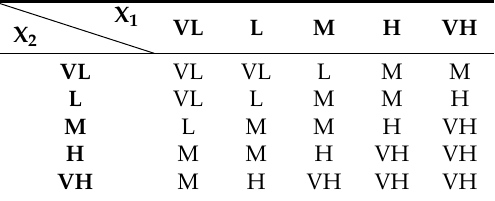
Table 2 indicates the fuzzy logic rules on the average rule-based method for M 1 _FIS. It is a 5 × 5 matrix and each entry in Table 2 is the water supply pipeline risk index. Table 2. Average rule-based mechanism for water supply pipeline risk index fuzzy logic.